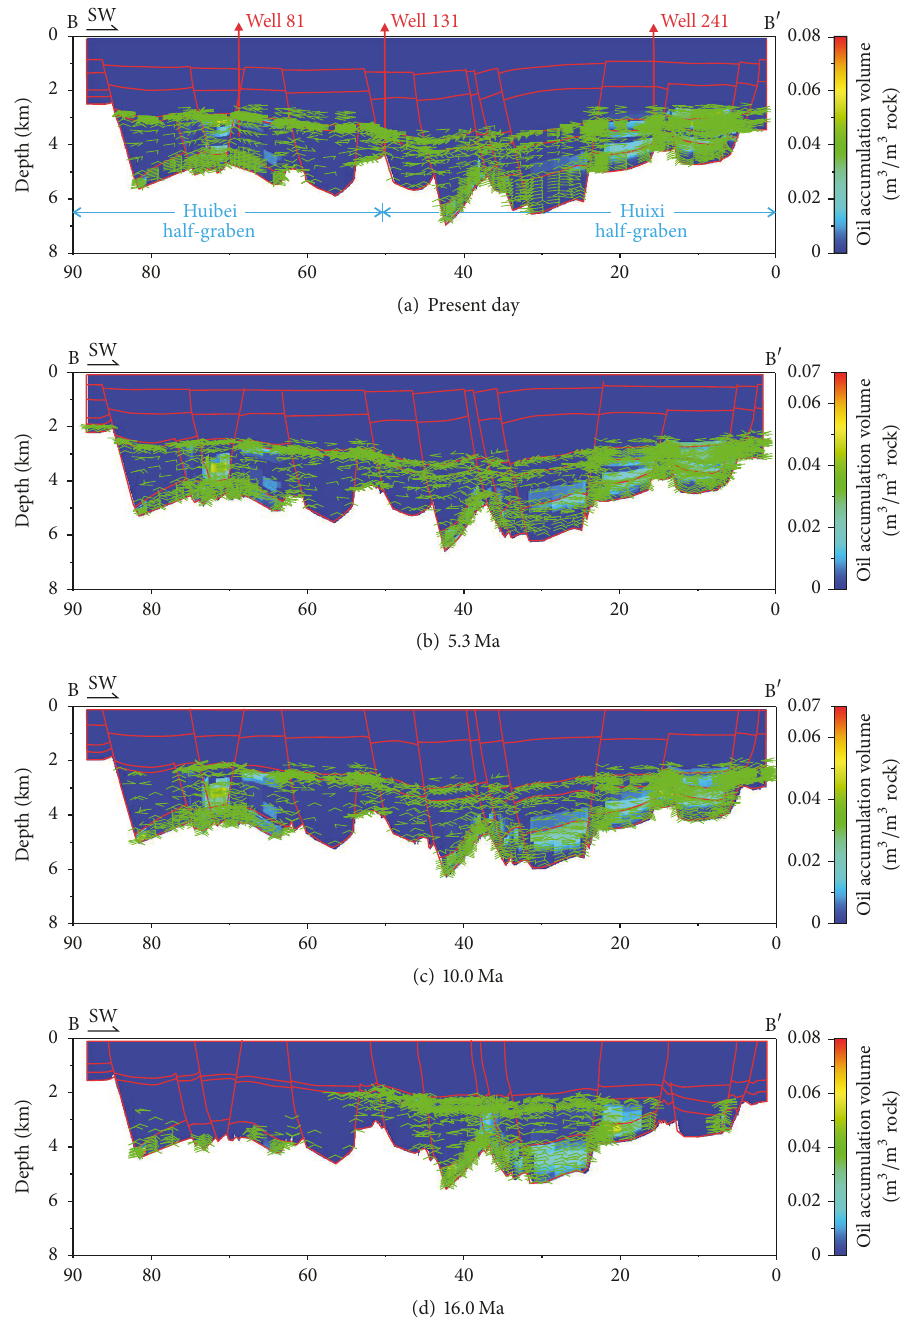
Figure 23: Dominant hydrocarbon fluid pathway and accumulation model of the Eocene source rocks during postrift and block faulting stage in the Huizhou Sag (the locations of three wells and profile BB 󸀠 are shown in Figure